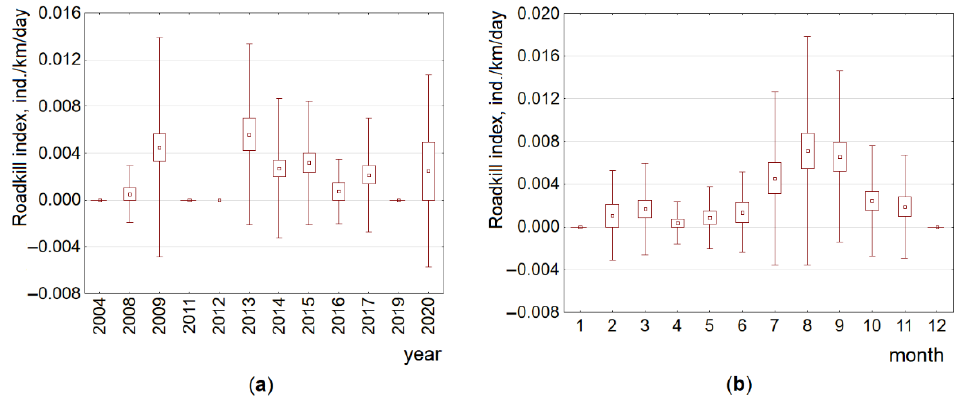
Figure 6. Raccoon dog roadkill trends by year ( a ) and by month ( b ) at the local scale on the A14 main road, 2004–2020. Data presented as averages, SE (box) and SD